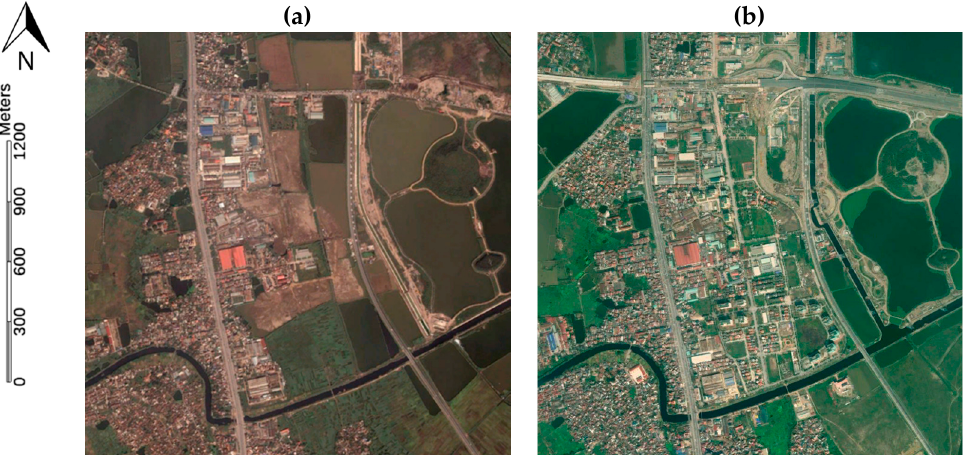
Figure 4. Optical image showing an example of new constructions of Hanoi testing area. The size of each image is 2 × 2 km. (a) Time 1 image from 15 November 2002, (b) Time 2 image from 9 February 2010.